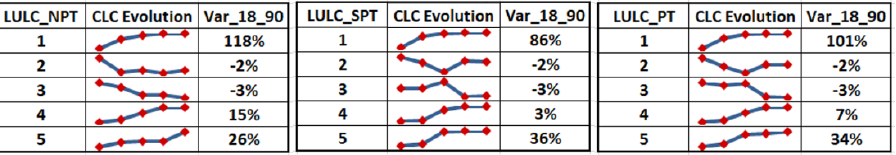
Figure 9. Tables showing Corine Land Cover evolution (CLC_Evolution) and variation (Var_18_90) for the main land use/land cover categories. 1-Artificial surfaces, 2-Agricultural area, 3-Forest and seminatural areas, 4-wetlands, 5-water bodies. Each red dot is referring to values estimated for the studied years (1990, 2000, 2006, 2012, and 2018). LULC (Land Use/Land Cover), NPT (North of Portugal), SPT (South of Portugal), PT (mainland Portugal).